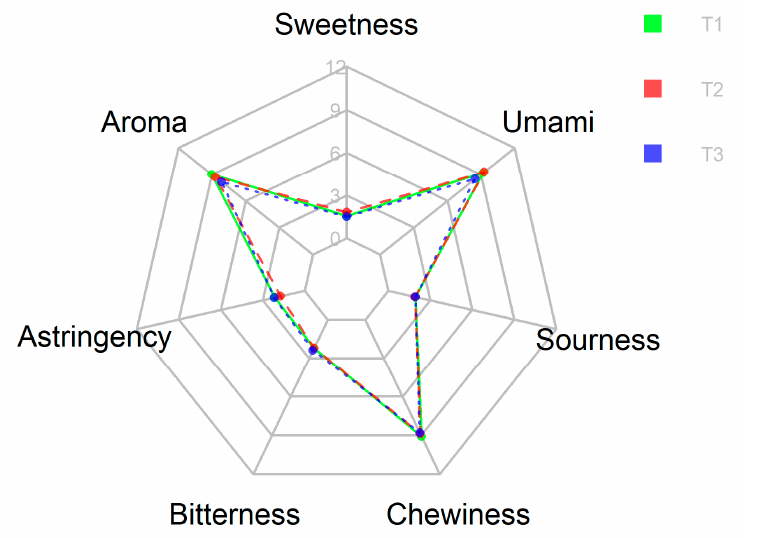
Figure 8. Radar chart for sensory attributes of oyster mushroom grown on different substrates. Legend: T1—pine sawdust; T2—coconut coir; T3—waste paper.